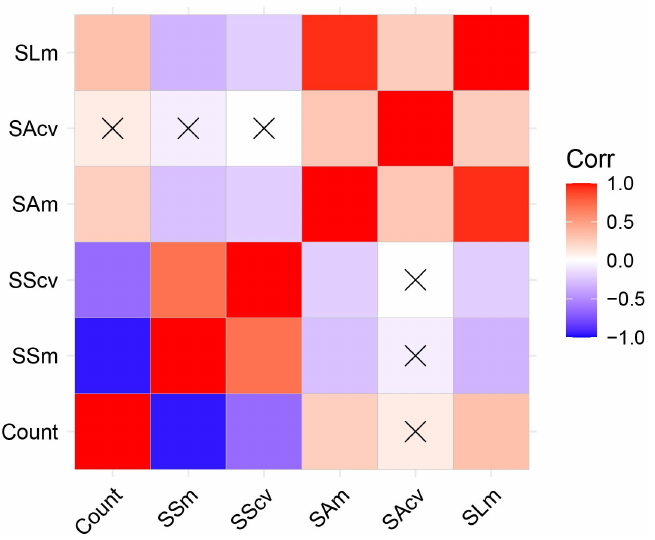
Figure 7 Figure 7. Correlation analysis between growth and distribution characteristics of seedlings at Zhangye Station in 2021. Count: seedling count; SSm: the average value of seedling spacing in the experimental plot; SScv: the coefficient of variation of seedling spacing in the experimental plot; SAm: the average value of seedling area in the experimental plot; SScv: the coefficient of variation of seedling area in the experimental plot; SLm: the average value of seedling spacing in the experimental